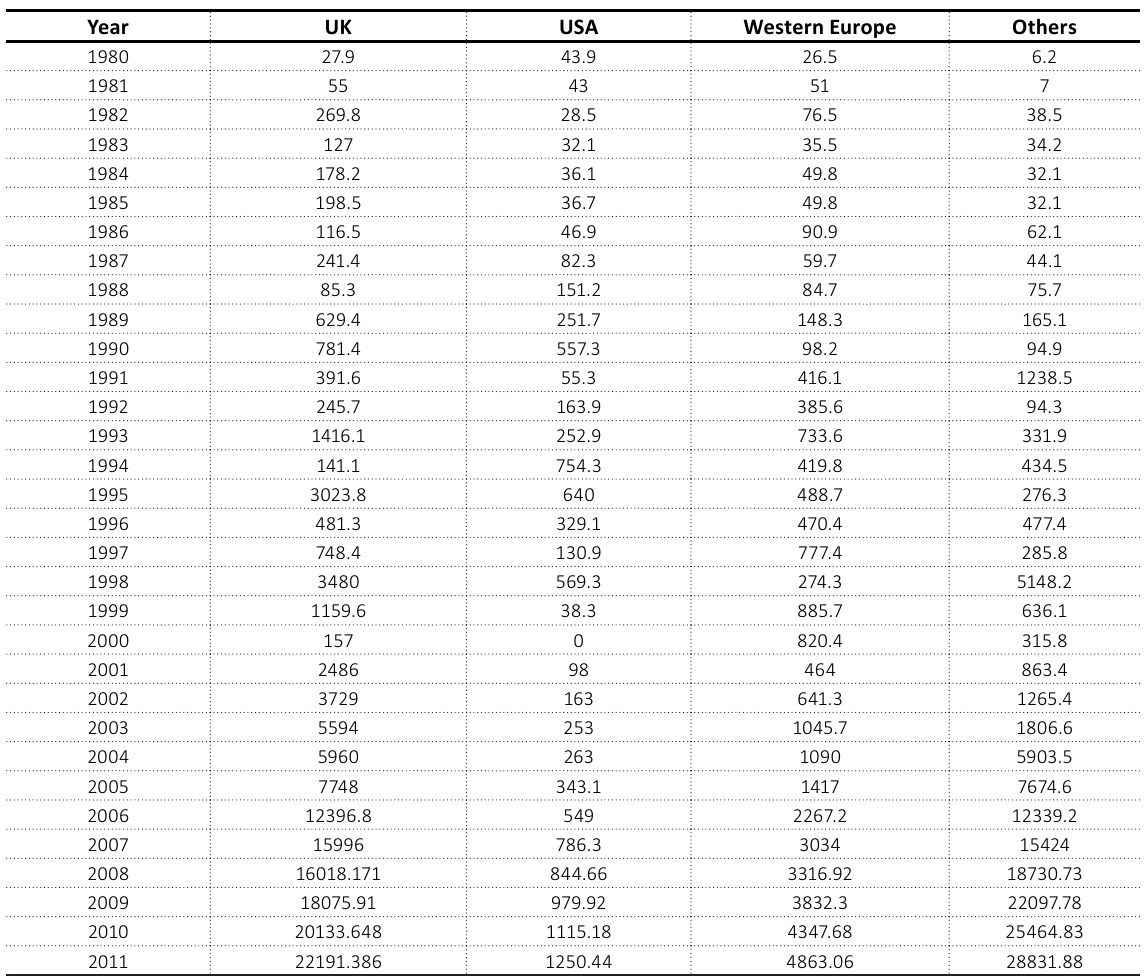
Source: CBN Statistical Bulletin,